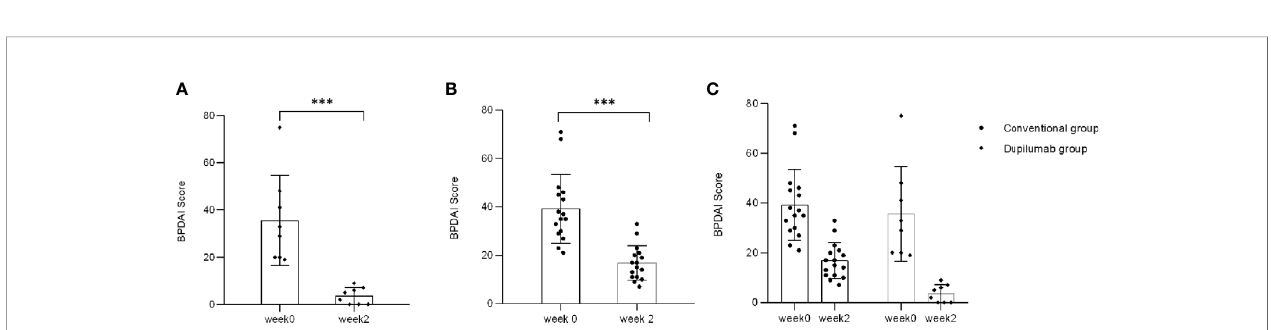
FIGURE 4 | Comparison of single BPDAI (skin: erosions/blisters) score between two treatment groups. BPDAI score has declined to varying degrees from weeks 0 to 2 in the dupilumab group (A) (*** p < 0.001 by Mann-Whitney U test) and the conventional group (B) (*** p < 0.001 by Mann-Whitney U test). (C) BPDAI score decreased more rapidly in patients in the dupilumab group than the conventional group ( p = 0.0308 by two-way RM